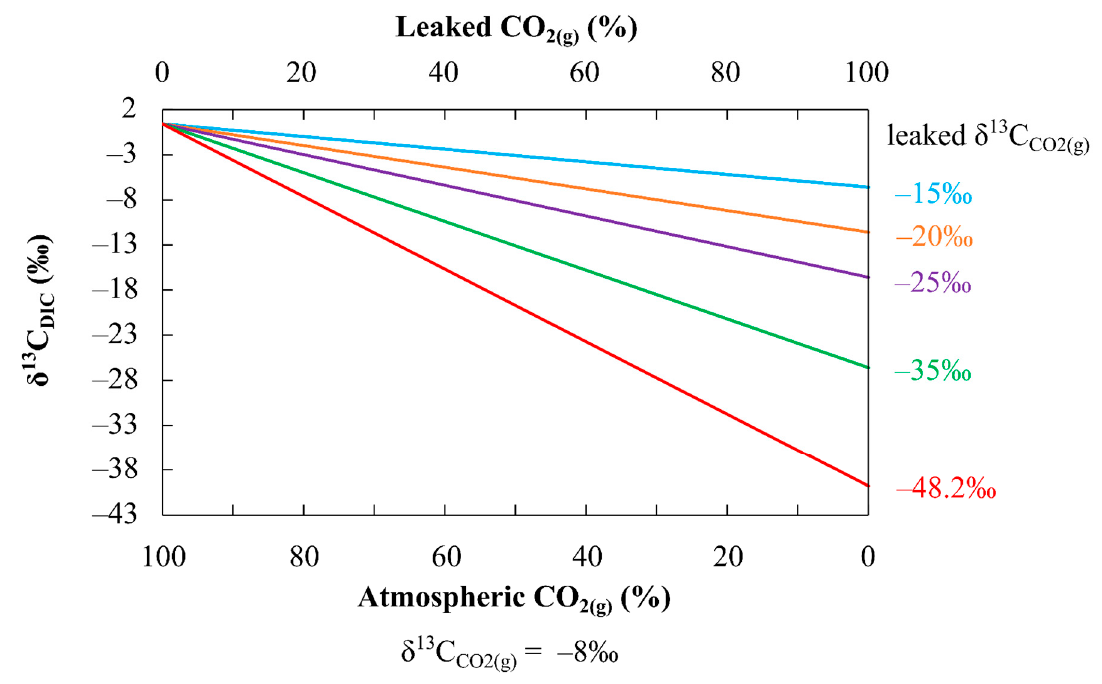
Figure 9. Predicted variation of δ 13 C DIC values according to the different δ 13 C of leaking CO 2(g) from carbon capture and storage sites (CCS) and to the different proportions of DIC composed by leaking or atmospheric CO 2(g) . The plots were produced applying the equation by Zhang et al. [76] assuming an atmospheric δ 13 C CO2(g) corresponding to − 8.0‰ and using different leaking δ 13 C CO2(g) values: − 15.0‰ (blue line), − 20.0‰ (orange line), − 25.0‰ (purple line) and − 35.0‰ (green line). The δ 13 C value of CO 2(g) used for the ASW experiments ( − 48.2‰) was also included (red line).